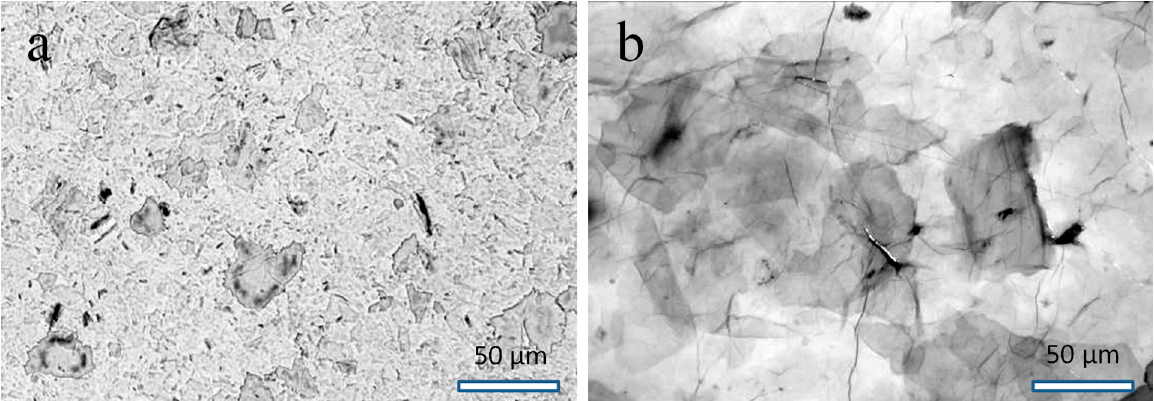
Figure 1. Optical micrographs of GO1 ( a ) and GO2 ( b ) samples.